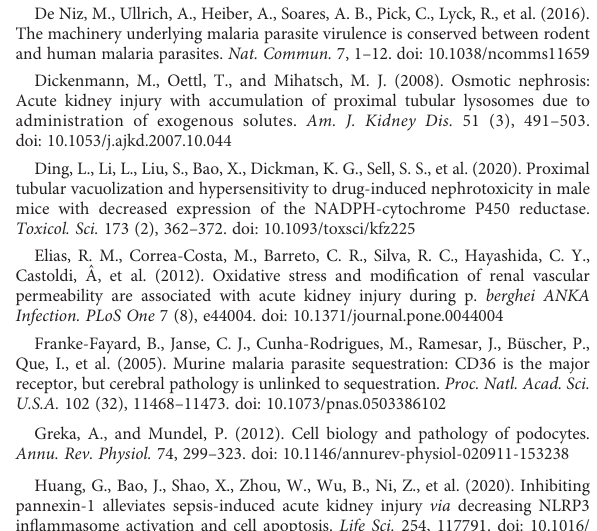
SUPPLEMENTARY FIGURE 2 Antimalarial treatment decreased collapse of glomerular capillary tuft in kidneys of PbNK65-E infected mice. C57BL/6 mice were infected with PbNK65-E parasites and kidneys were dissected at the indicated times. From day 8 p.i., mice were treated daily with antimalarial drugs (ART + CQ). Sections were stained with PAS. Representative images are shown (original magni fi cation x20, bar= 100 µm). Red frames indicate collapse of glomerular